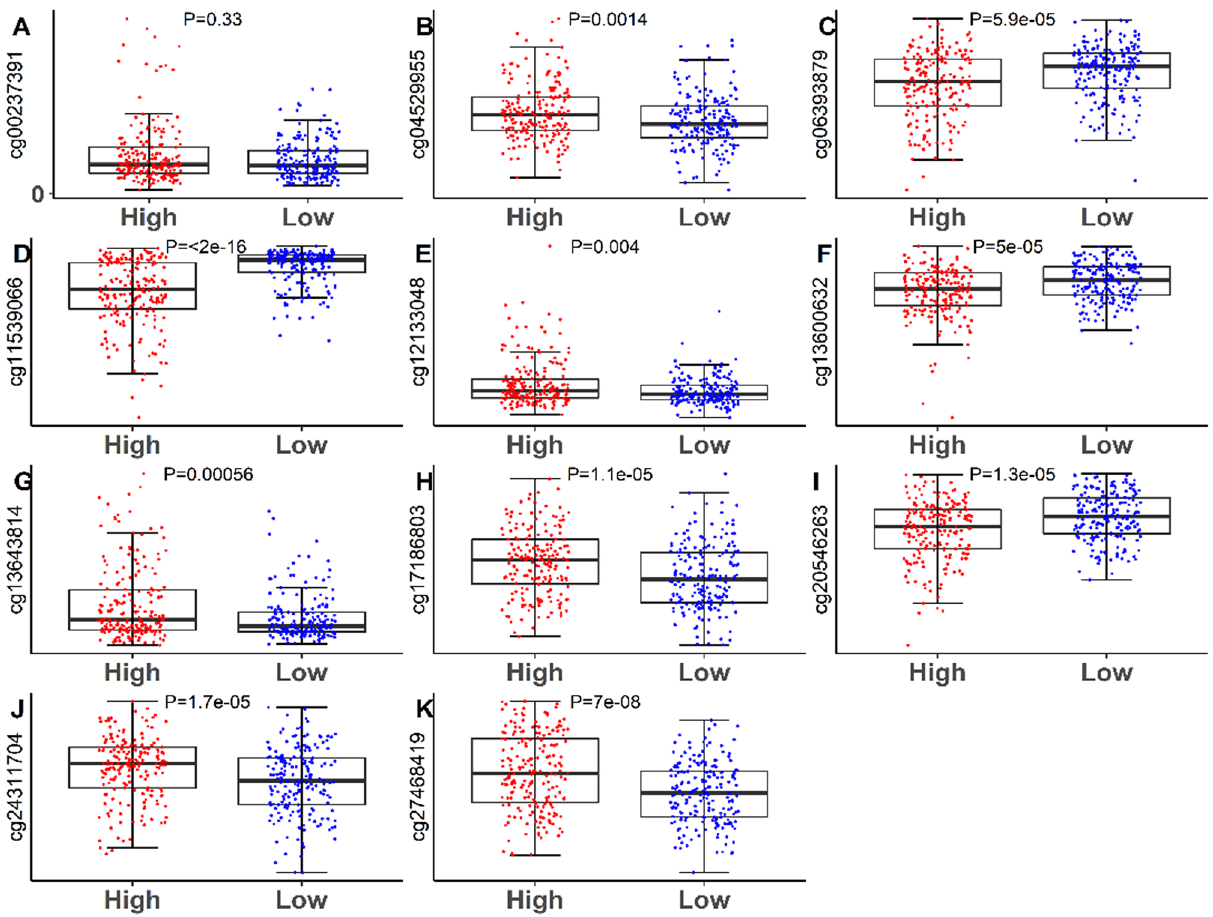
Figure 3. Boxplots of methylation β values against risk group in the entire TCGA dataset. “High Risk” and “Low Risk” represent the high-risk and low-risk samples, respectively. The median risk score was applied as a cutoff. Vertical coordinates represent the β-value of 11-DNA methylation sites respectively. Mann–Whitney U test was employed to assess the diferences between the high-risk score and low-risk score